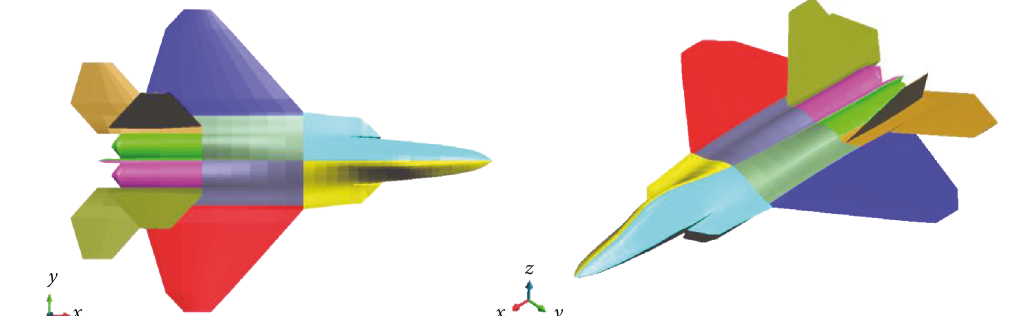
Figure 13: Bistatic RCS of the aircraft.